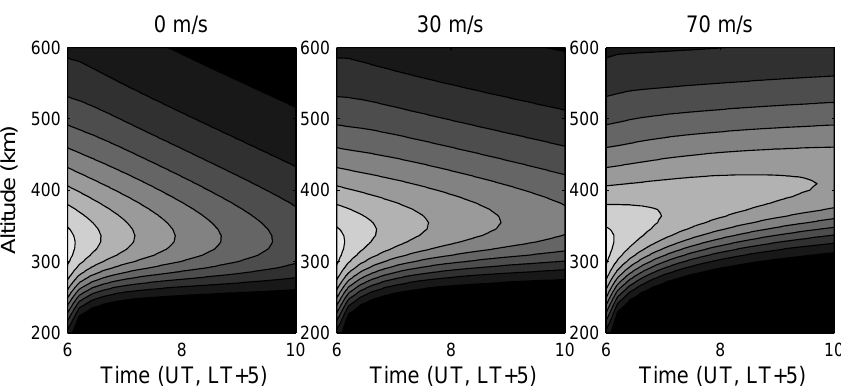
Fig. 9. Contour plots of the electron density for the different values of a constant neutral wind as described in the text. The scale is the same as that in Fig.